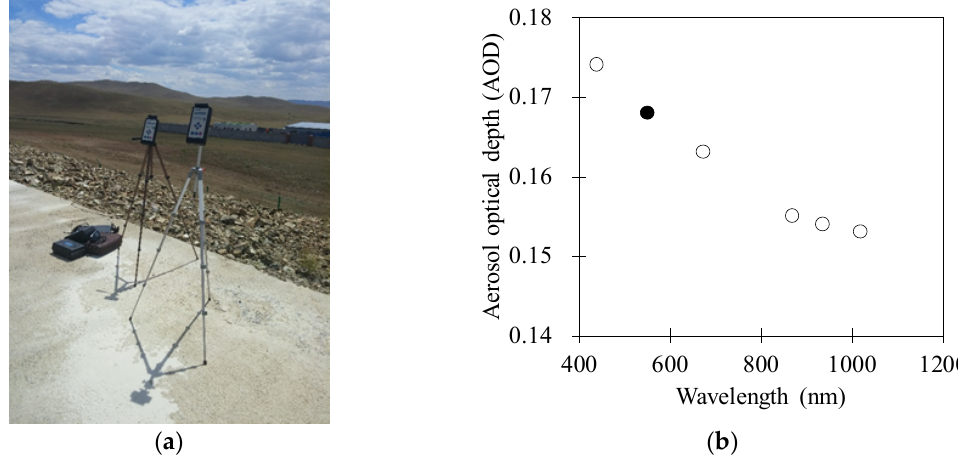
Figure 8. ( a ) Picture of the Microtops II ® Sunphotometer and Ozonometer, developed by (Solar Light Inc., Glenside, PA, USA) deployed at the Zuunmod site in Mongolia and ( b ) the measured and estimated aerosol optical depth (AOD) using the Sunphotometer. White circles are the measured AODs (440–1020 nm) while the black circle is the estimated AOD in 550 nm using the Ångström exponent based on the AODs in the 440 and 870 nm channels. Table 3. Measured water vapor, total ozone, and aerosol optical depth (AOD) using the Microtops II ® Sunphotometer and Ozonometer (Solar Light Inc., Glenside, PA, USA).